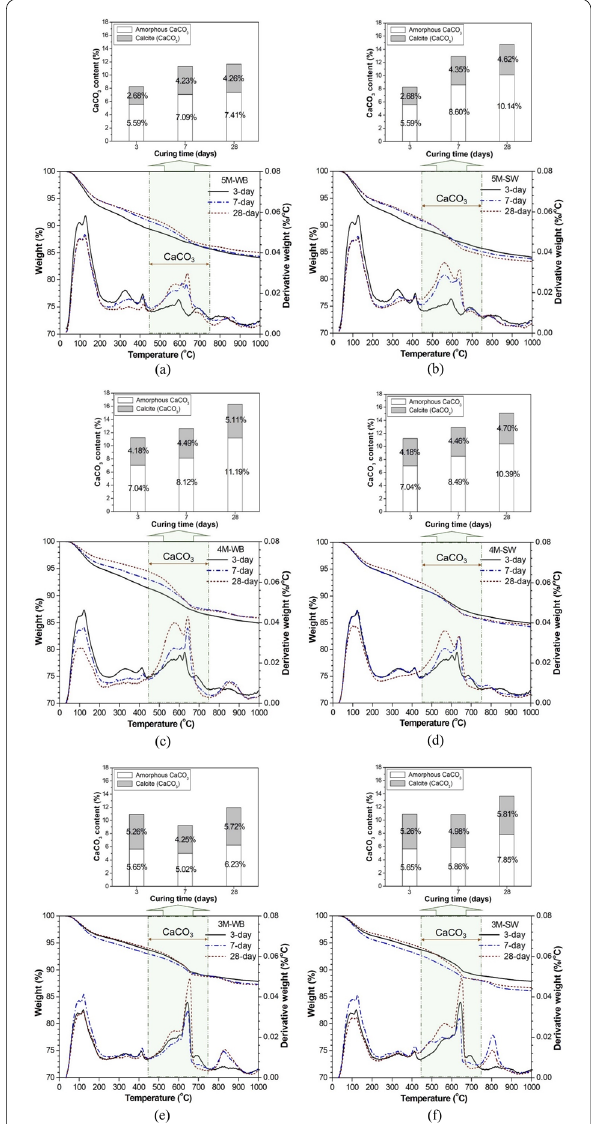
Fig. 4 TG and DTG curves for the thermal decomposition of ( a ) 5M-WB, ( b ) 5M-SW, ( c ) 4M-WB, ( d ) 4M-SW, ( e ) 3M-WB, and ( f ) 3M-SW samples. 3 days: when CO 2 curing was finished; 7 and 28 days: after subsequent curing in water bath (WB) or immersion in seawater